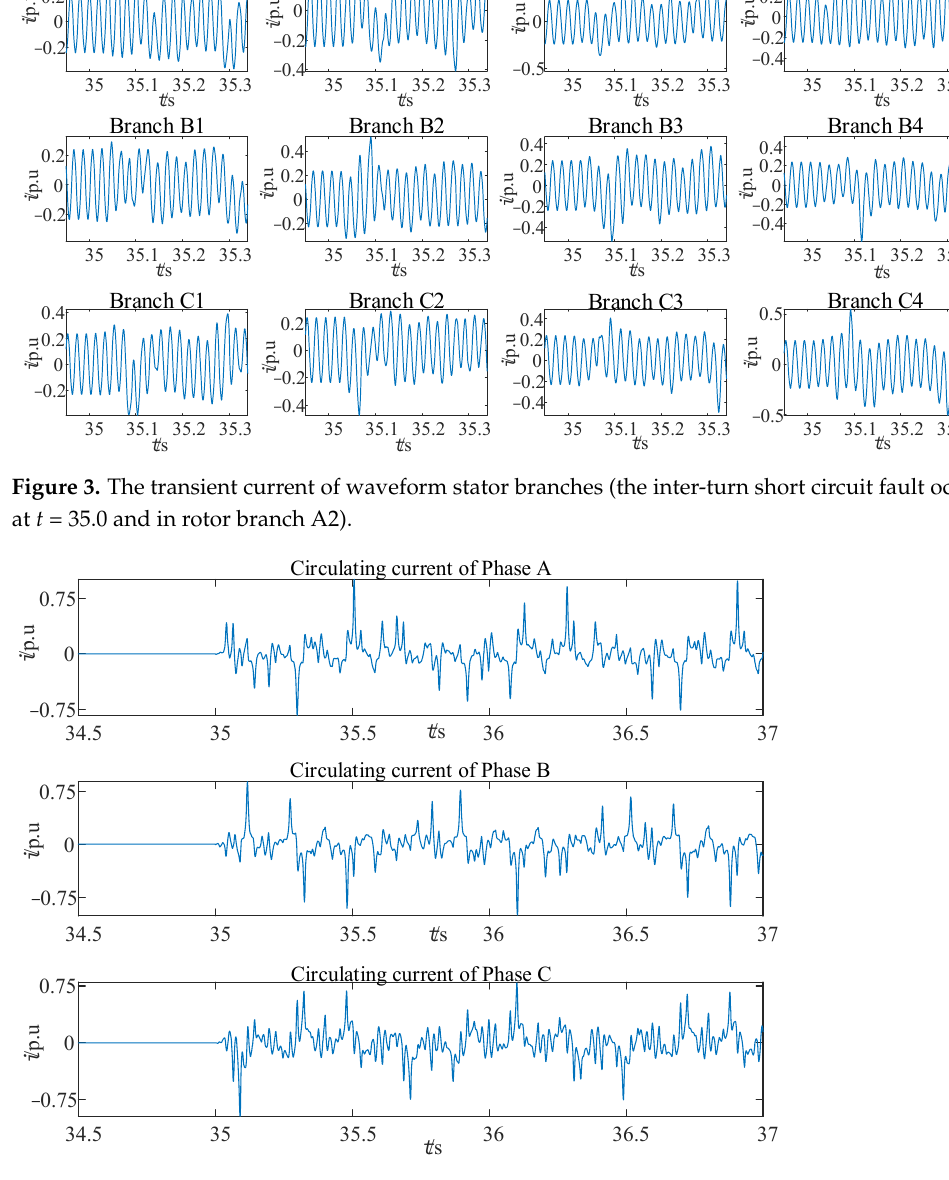
Figure 3. The transient current of waveform stator branches (the inter ‐ turn short circuit fault occurs at t = 35.0 and in rotor branch A2).